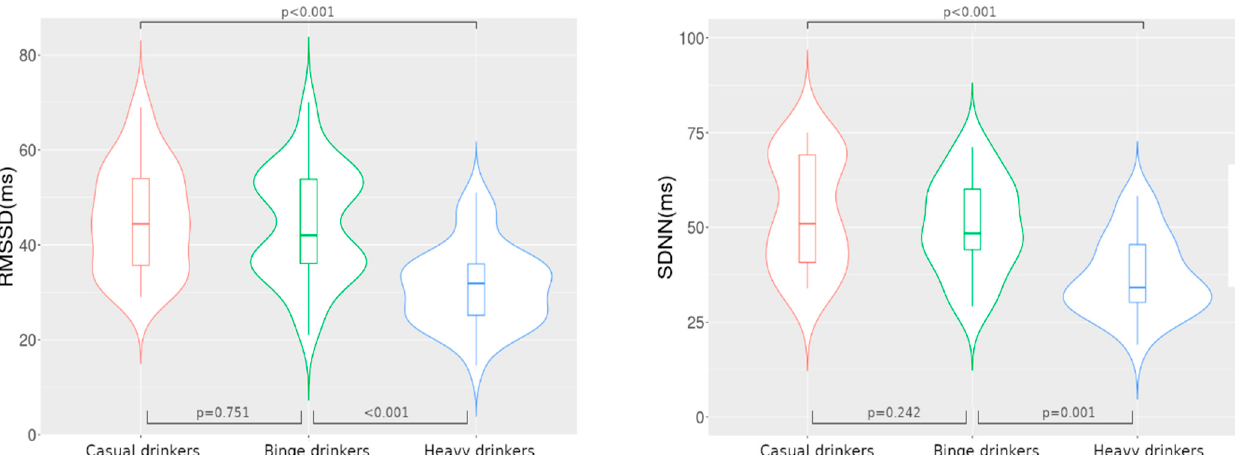
Figure 1. The boxplot inside violin represents the median and interquartile range. RMSSD (root mean square of the successive differences) and SDNN (standard deviation of RR intervals) violin plots of drinking patterns (casual = 45, binge = 62, heavy = 35). Post-hoc analysis using Whitney–Mann U tests. The p -value was adjusted with Bonferroni correction for pairwise comparison.